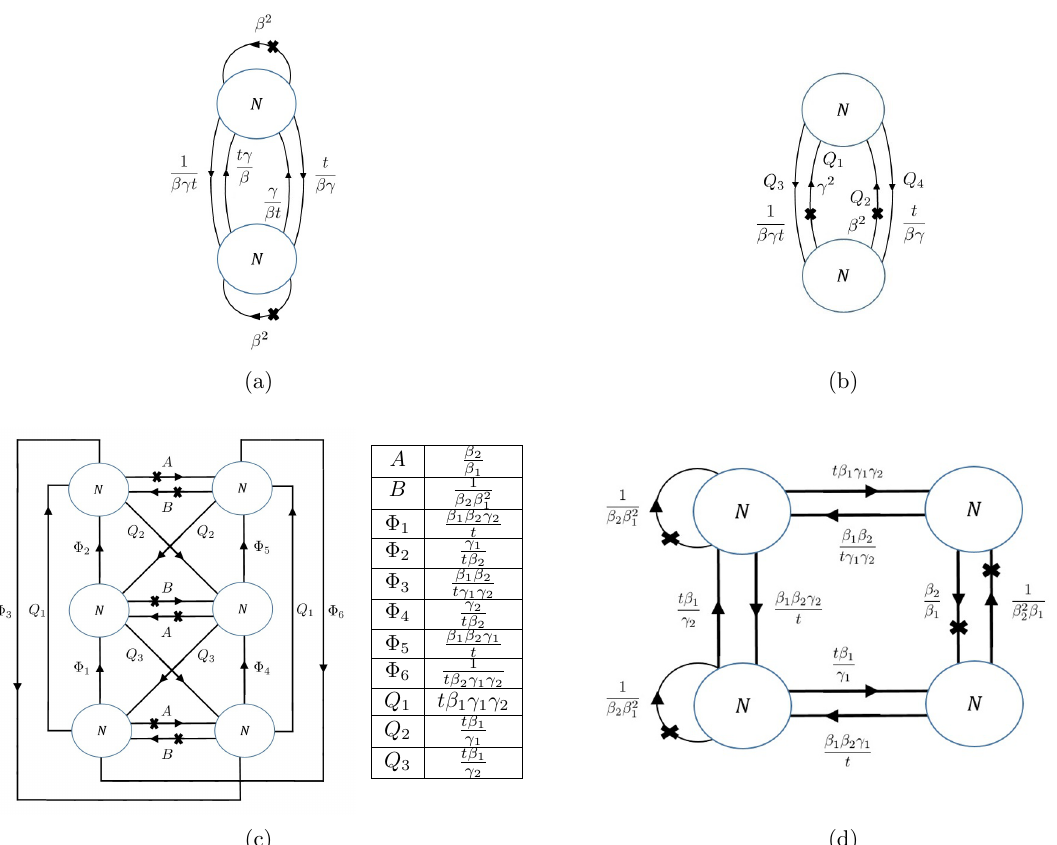
Figure 4 : The quiver diagram for the 4d class theory corresponding to a torus with Figure 5 : The quiver diagram for the 4d class theory corresponding to a torus with flux S 2 S 2 flux (1 , 0 , 0). Next to the fields are their charges summarized through fugacities. We use ( 1 2 , 1 2 , 0). Next to the fields are their charges summarized through fugacities. The theory has a mostly standard notation except for two points: lines from a group to itself represent N 2 quartic superpotential involving the four bifundamentals as well as the superpotential coming hypermultiplets forming the adjoint plus singlet representations of the group; we write an X from the flipping. There is also an R -symmetry where it is convenient to give R -charge 1 2 to N the four bifundamentals Q i and R -charge 2 over a field to represent the fact that the baryon of that field is flipped. The theory has a cubic 2 to the flipping fields ,  .  superpotential for every triangle which can also be derived by considering the most general cubic superpotential that is gauge invariant and consistent with the symmetry allocation. There is also the superpotential term which is not generally cubic coming from the flipping. All fields, save the flipping fields, have the free R -charge 2 3 .